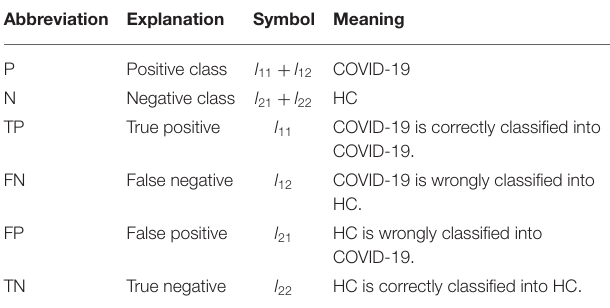
TABLE 4 | Definitions in the confusion matrix.